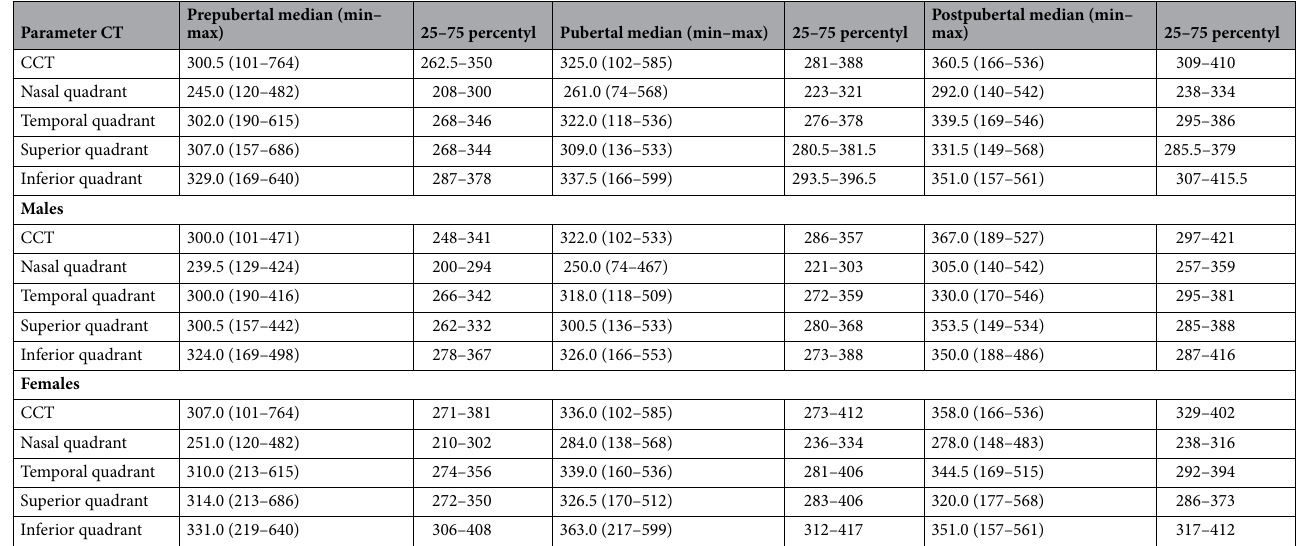
Table 4. The differences between CT in prepubertal, pubertal and postpubertal